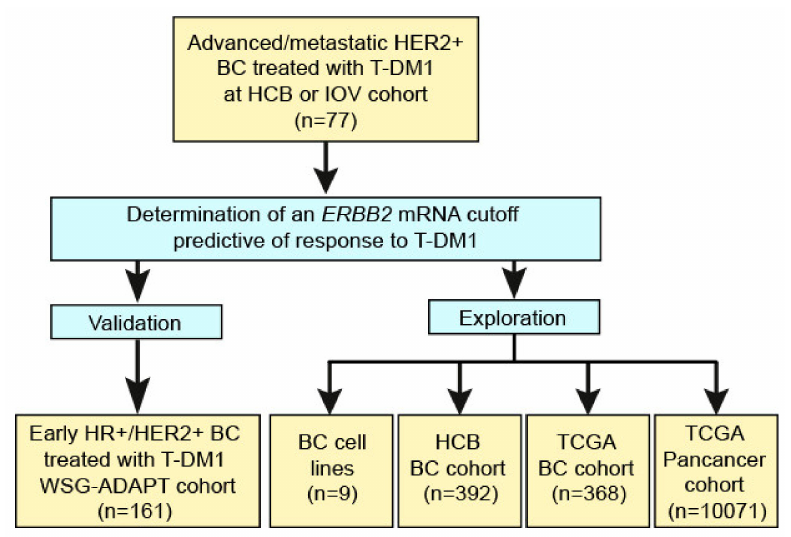
Figure 1. Workflow of the study.